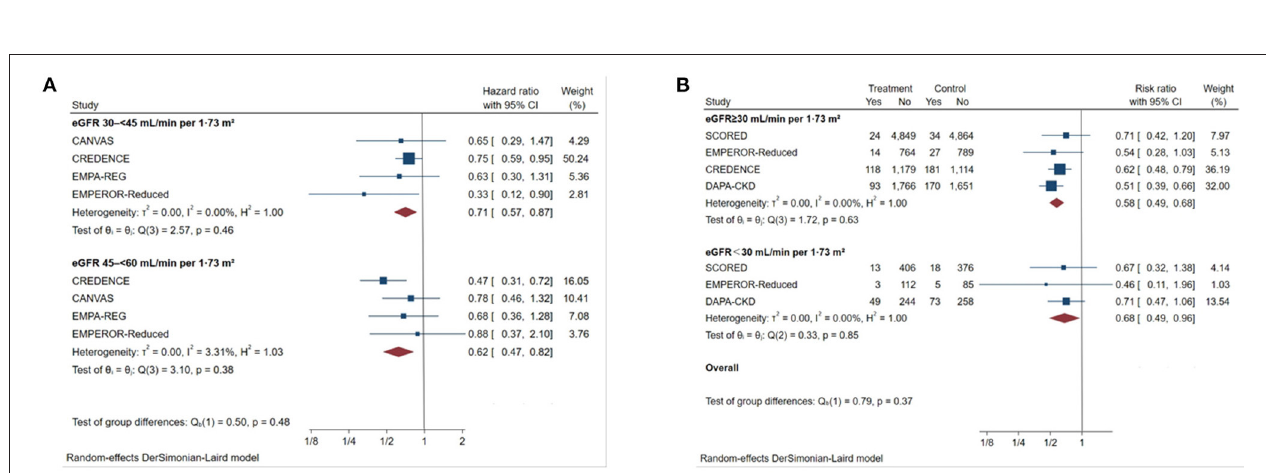
FIGURE 3 | Effect of SGLT2 inhibitors on ESKD, worsening kidney function, or death because of kidney disease across the spectrum of different levels of eGFR. (A) Patients with eGFR 45–60 mL/min/1.73 m 2 ; (B) patients with eGFR < 30 mL/min/1.73 m 2 . CI, confidence interval; eGFR, estimated glomerular filtration rate; worsening kidney function: defined as doubling of serum creatinine or sustained 40% decline in eGFR; ESKD, defined as requirement for chronic dialysis or kidney transplantation, or sustained eGFR < 15 mL/min/1.73 m ² .